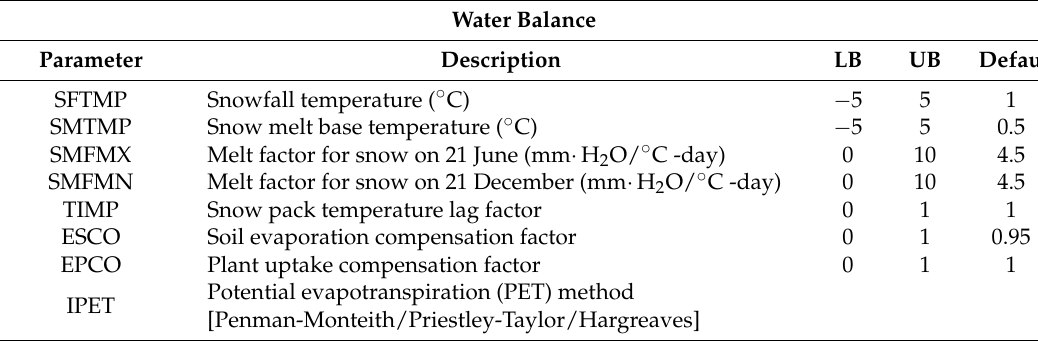
Table A1. Adjustable SWAT parameters for water balance functions.